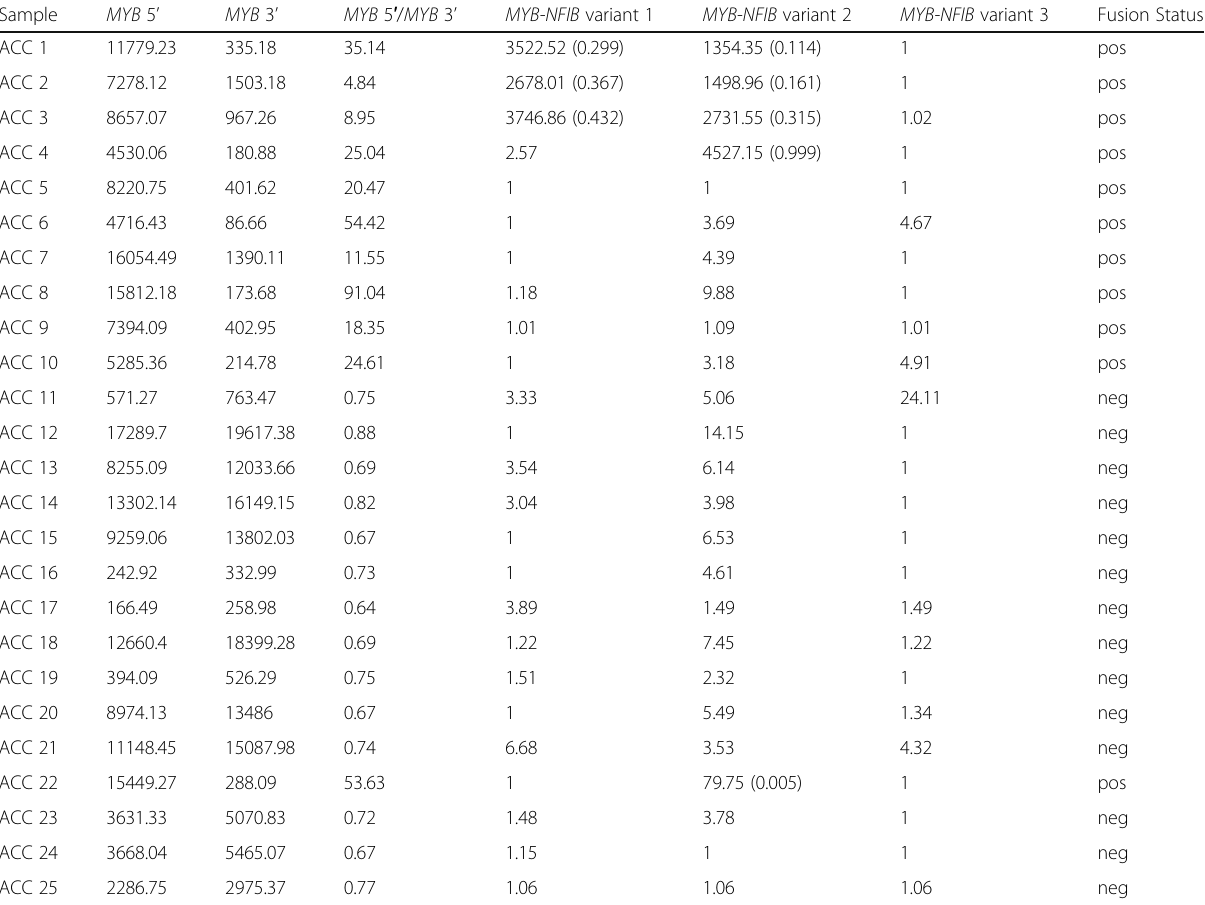
Table 3 MYB 5 ′ / MYB 3 ′ and MYB-NFIB variant gene expression by NanoString digital counting